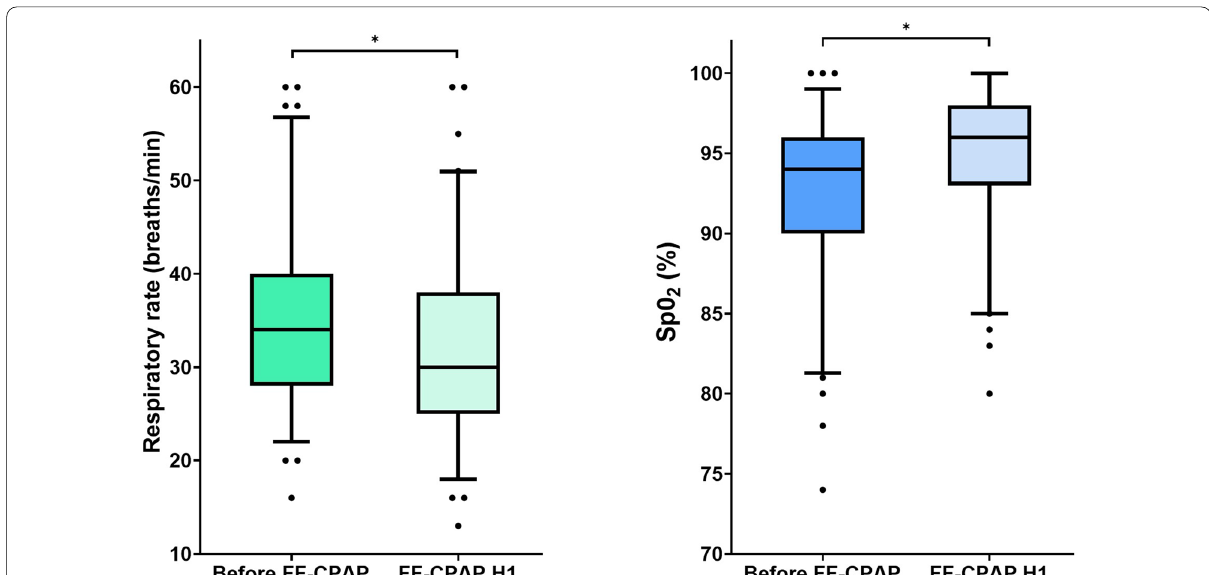
Fig. 4 Clinical study. Effect of FF‑CPAP on respiratory rate ( a ) and SpO 2 ( b ). Respiratory rate and SpO 2 were recorded before FF‑CPAP initiation and then during the first hour of FF‑CPAP therapy (FF‑CPCP